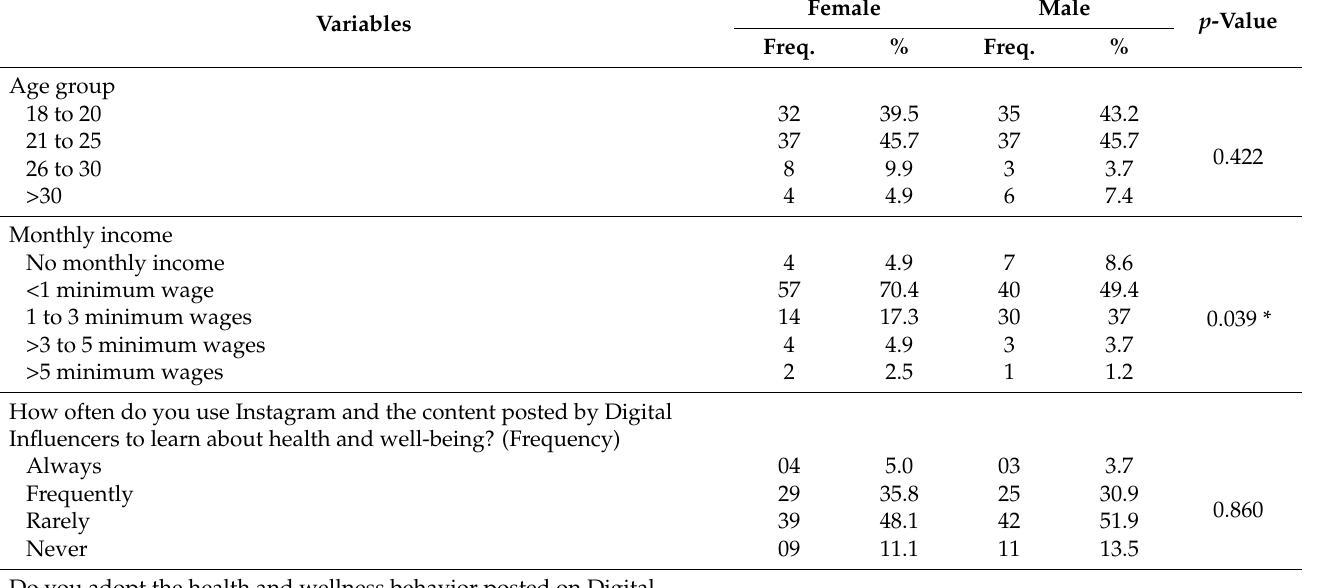
Table 2. Simple frequency and percentage values of responses related to the use of Instagram according to